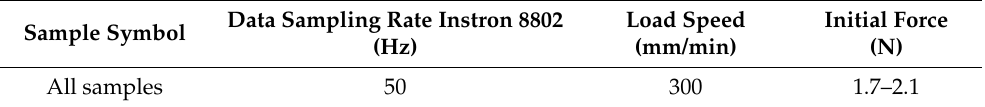
Table 2. Parameters of Instron 8802 testing machine.